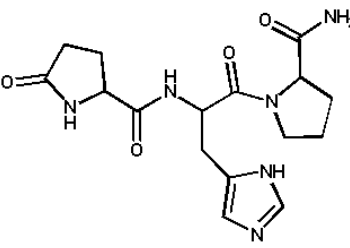
Figure 1. Chemical structure of thyrotropin-releasing hormone (TRH, pGlu-His-Pro-NH